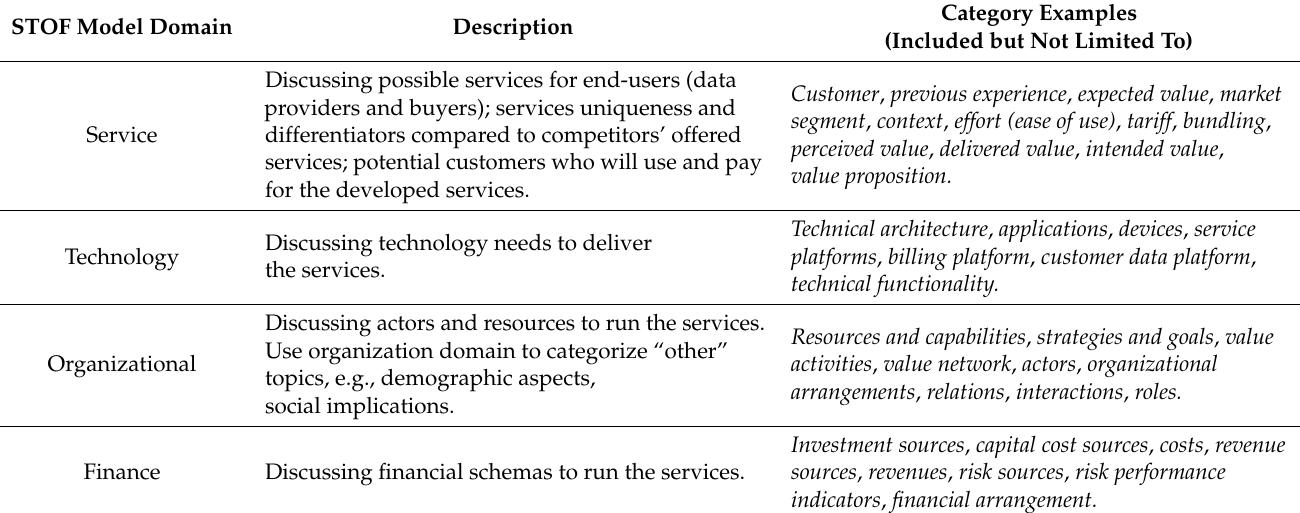
Table 1. The guideline to categorize the